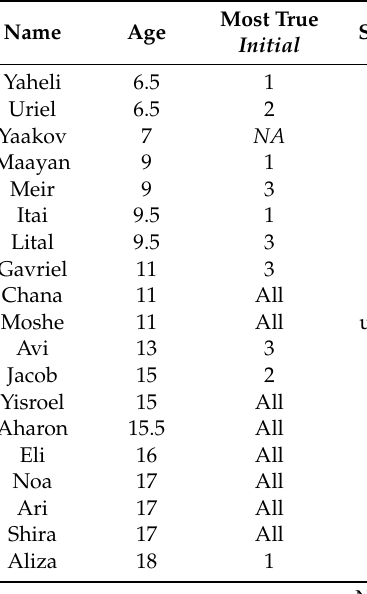
Table 1. Student Responses. 1 = Midrash, 2 = Translation, and 3 =